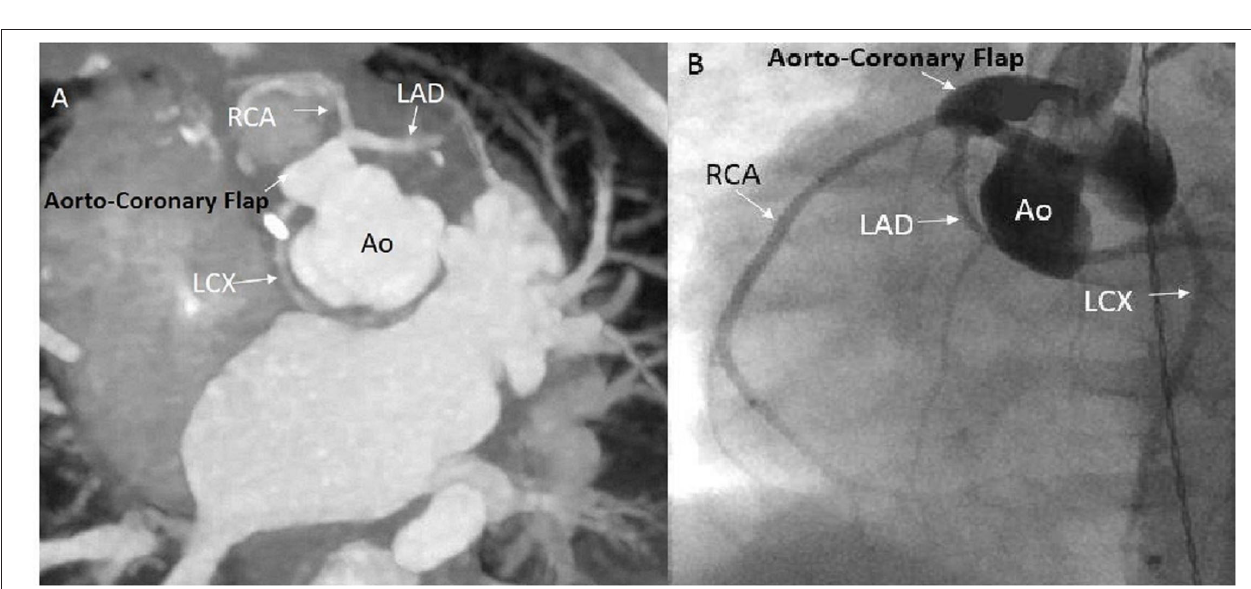
FIGURE 3 | Computed tomography depicting the coronary arteries after initial surgery: (A) narrowing of the main segment. (B) Normal left circumflex filling with no obvious narrowing. Ao, aorta; RCA, right coronary artery; LAD, left anterior descending coronary artery; LCX, left circumflex coronary artery.